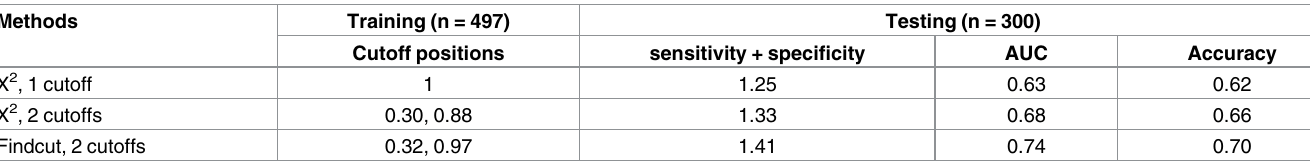
Table 6. Comparison of Findcut and X 2 : Stromal invasion vs. LVSI.